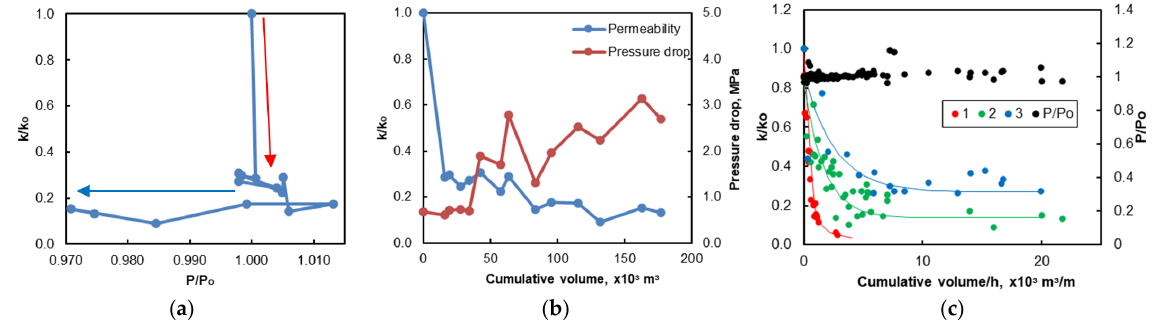
Figure 4. ( a ) Change in relative permeability on relative effective pressure. The red arrow shows the load stage, the blue arrow shows the unloading stage; ( b ) change in relative permeability and pres- sure drop on cumulative produced oil of one of the wells; ( c ) change in relative permeability and relative effective pressure on specific volume (cumulative produced oil divided by formation thickness) for 20 wells operating the C 1 tl terrigenous formation. The circles show the actual values, the solid lines show the model values.